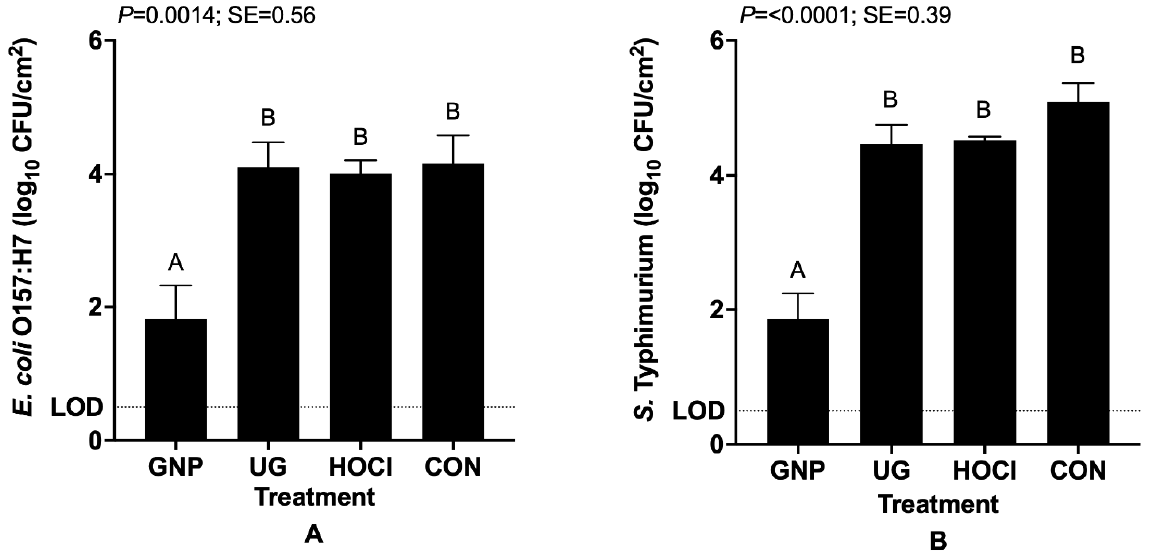
Figure 1. Least squares means of surviving E. coli O157:H7 ( A ) and S. typhimurium ( B ) cells on inoculated and treated tomato samples. Treatments are GNP (0.5 wt.% geraniol in polymeric nanopar- ticles), UG (0.5 wt.% unencapsulated geraniol in sterile distilled water), HOCl (200 mg/L pH 7.0 hypochlorous acid), CON (sterile distilled water). Bars represent means of triplicate identical repli- cates ( n = 3); error bars depict the standard error of means. SE: pooled standard error. Bars not shar- ing a capitalized letter (A, B) differ at p = 0.05 by one-way analysis of variance and Tukey’s Honestly Significant Differences test.